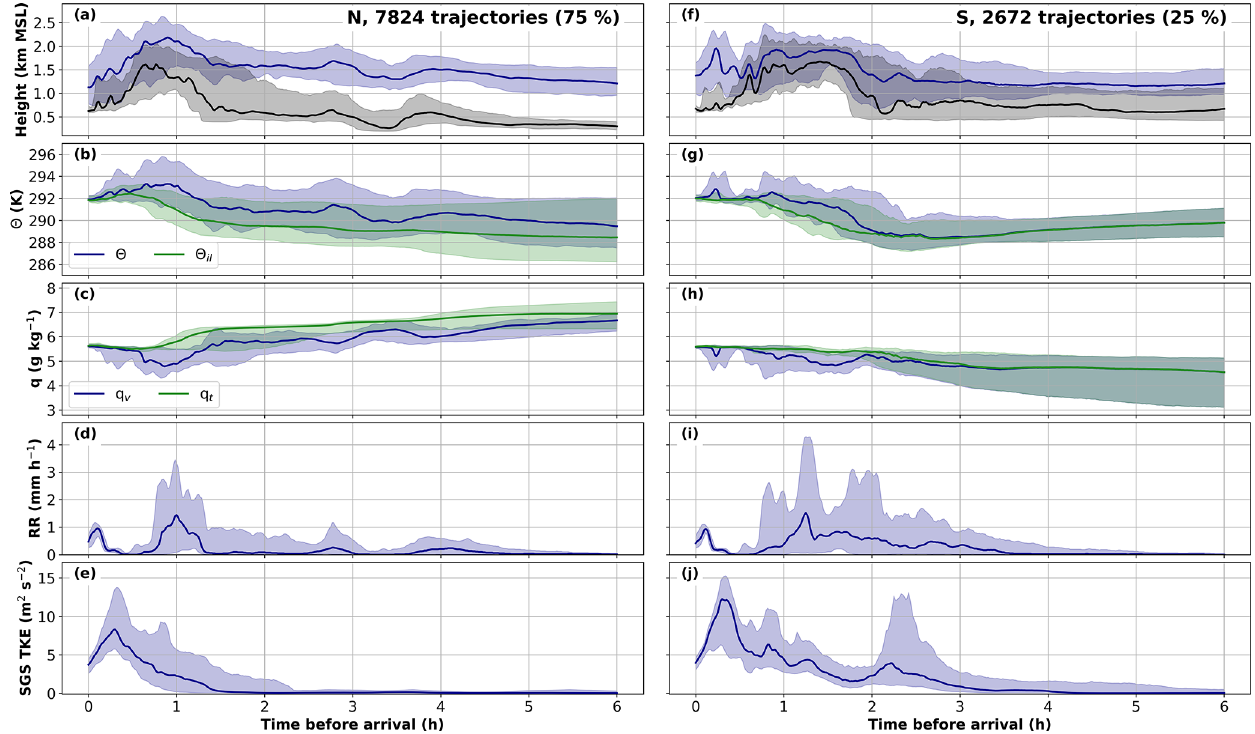
Figure 9. Temporal evolution of trajectory properties for trajectories as shown in Fig. 7 starting north (left column) and south of 47.2 ◦ N (right column). Thick lines indicate the median and shadings the 10th and 90th percentile. (a, f) Trajectory height (blue) and terrain height (black) (in kma.m.s.l.); (b, g) θ (blue) and θ il (green) (in K); (c, h) q v (blue) and q t (green) (in gkg − 1 ); (d, i) precipitation intensity at the surface (in mmh − 1 ); and (e, j) subgrid-scale (SGS) TKE (in m 2 s − 2